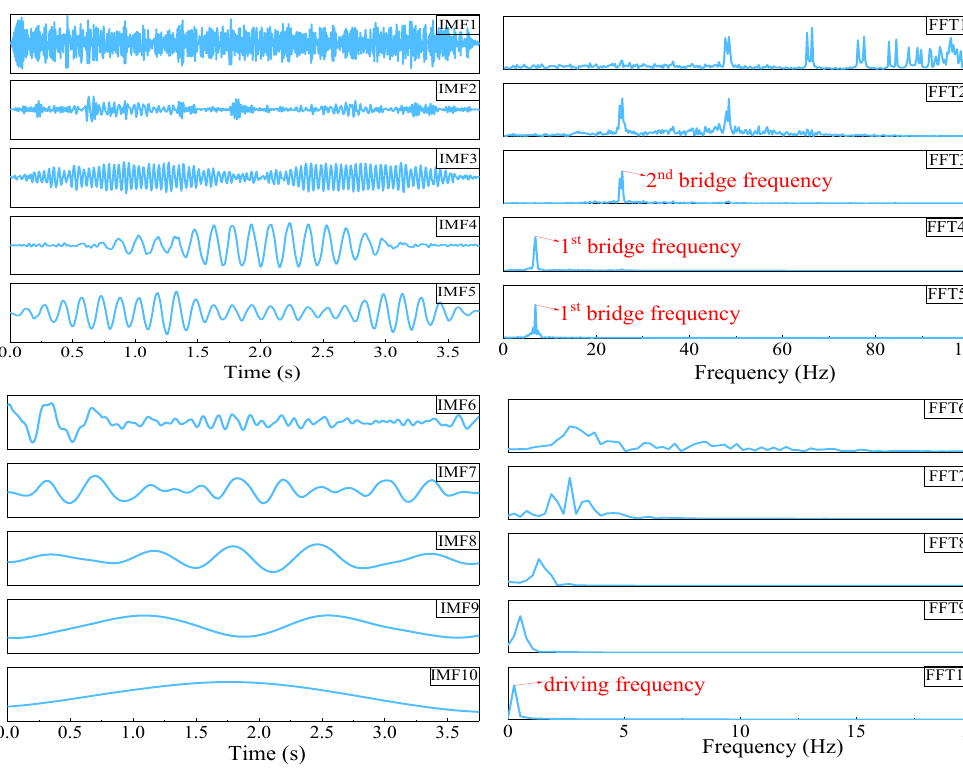
− Figure 9. CWC extracted using different methods: ( a ) EEMD; ( b ) CEEMDAN. 3.4. CWC for Multi ‐ Damage Case In this section, the performance of the proposed drive ‐ by damage inspection meth ‐ odology in a multi ‐ damage case is further evaluated. Two damage scenarios of the bridge girder with two damage locations are investigated. In the first damage scenario (case 12), elements No. 4 and No. 14 are damaged with a severity of 10% and 30%, while in the second damage scenario (case 13), elements No. 4 and No. 14 are damaged with a severity of 30% and 10%. Figure 10 shows the CWC by analyzing the bridge mid ‐ span acceleration, vehicle acceleration, and contact ‐ point acceleration. As shown in Figure 10a, the CWC extracted from the bridge mid ‐ span acceleration has a poor damage inspection perfor ‐ mance. In contrast, as for the CWC extracted from the vehicle acceleration and contact ‐ point acceleration, two noticeable peaks can be observed at the two damaged elements, as shown in Figure 10b,c. In addition, for damage scenario one, the peak at element No. 4 with a 10% damage severity is less than that at element No. 14 with a 30% damage